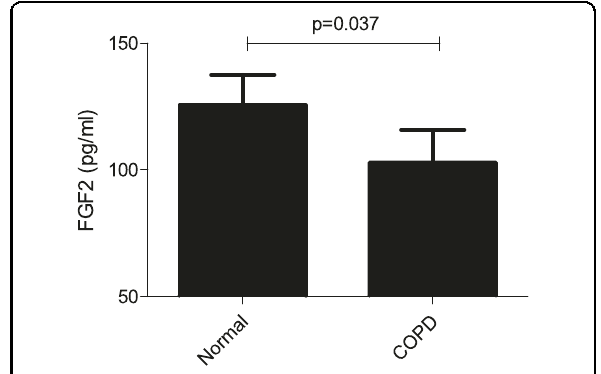
Fig. 6 FGF-2 levels in plasma from patients with chronic obstructive pulmonary disease (COPD) and normal controls. A 100-µL aliquot of plasma was used to measure FGF-2 ( n = 10/group). P = 0.037 according to the Mann – Whitney test